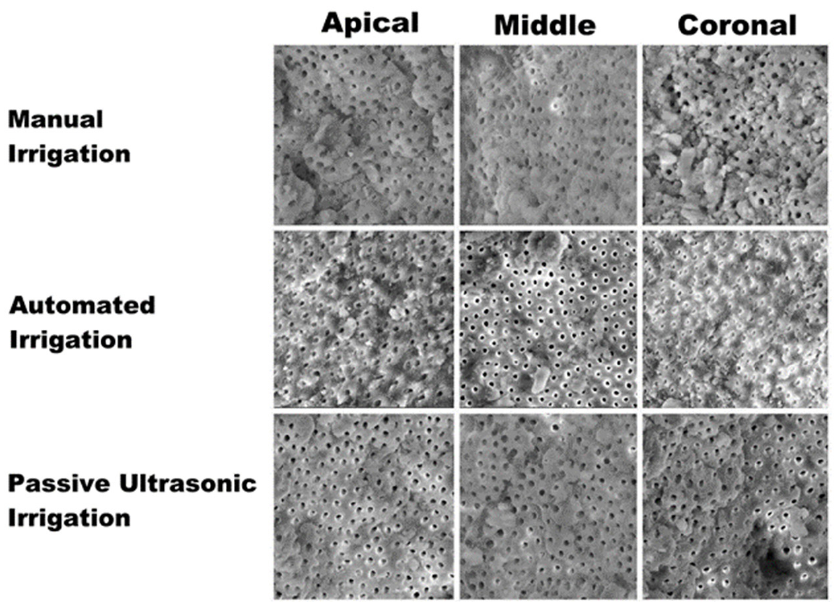
Figure 3. Scanning electron microscopy images showing the smear layer removal at apical, middle, and coronal sections with regard to different irrigation techniques. Table 1. Mean distribution of debris and smear scores among different irrigation modes.